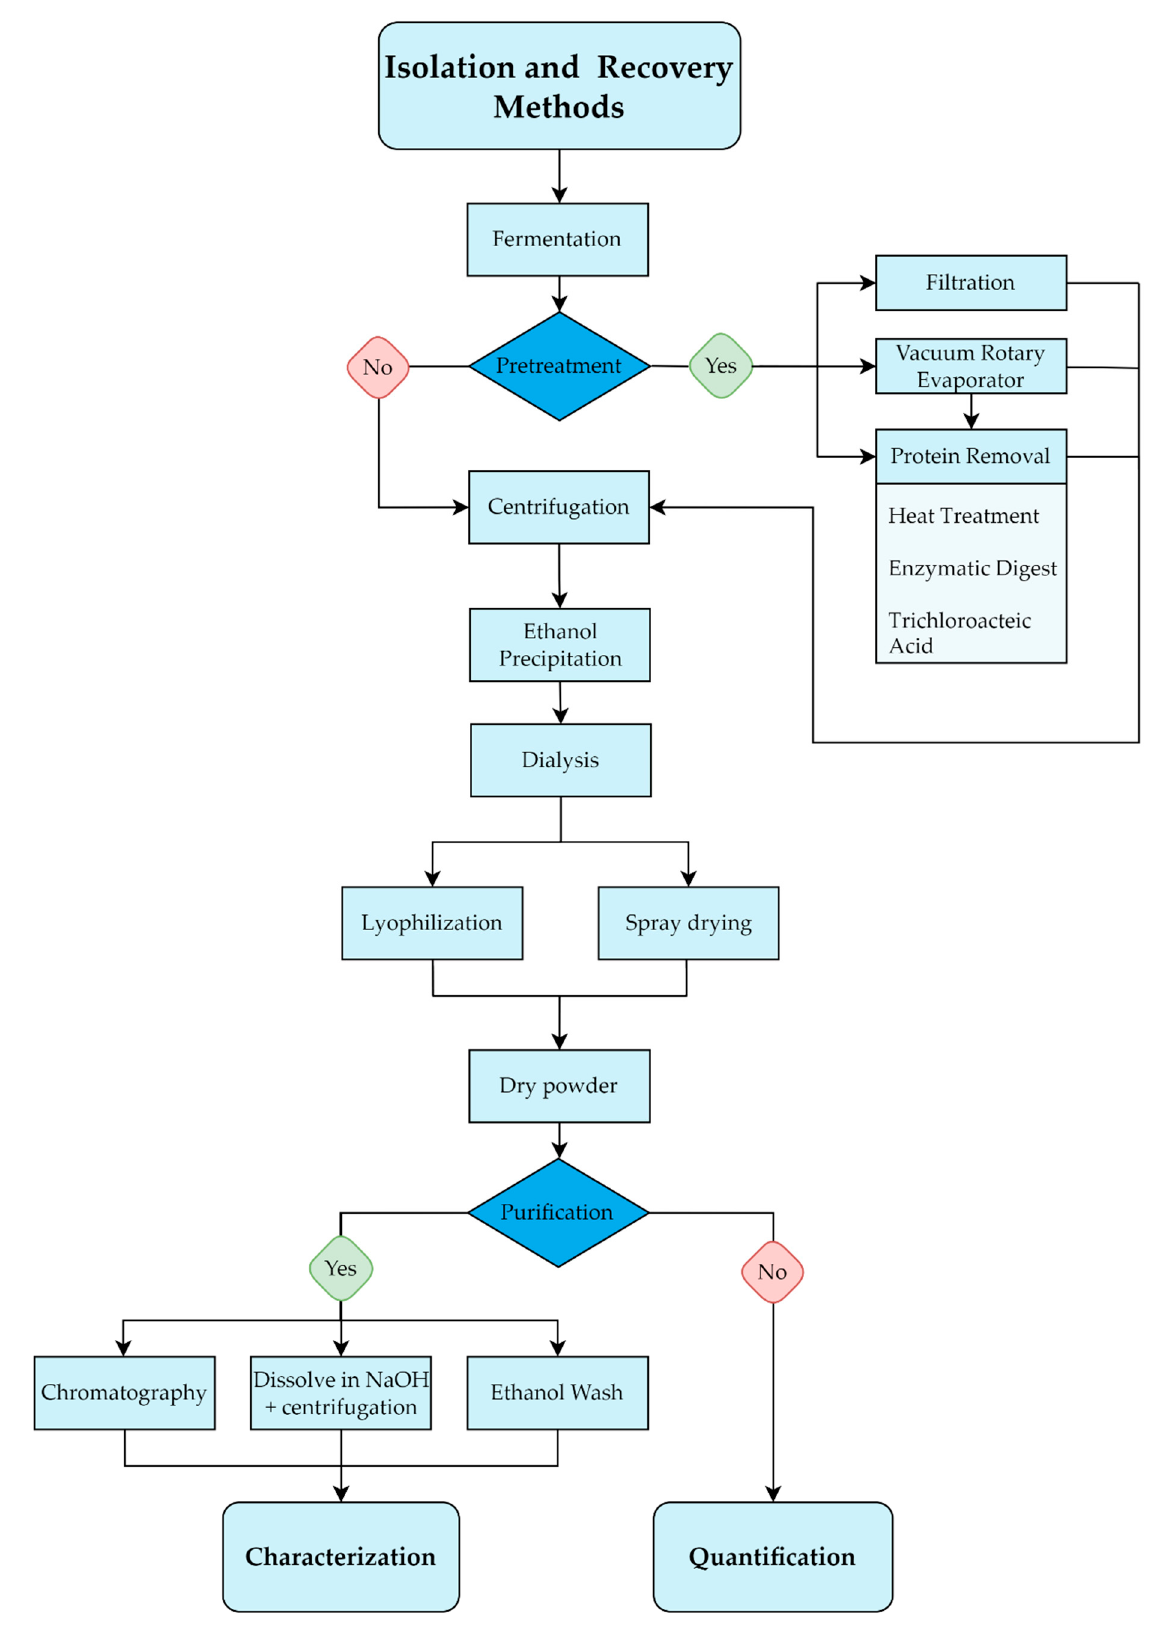
Figure 8. Diagram of isolation and recovery of EPS from the end of fermentation to either characterisation or quantification.